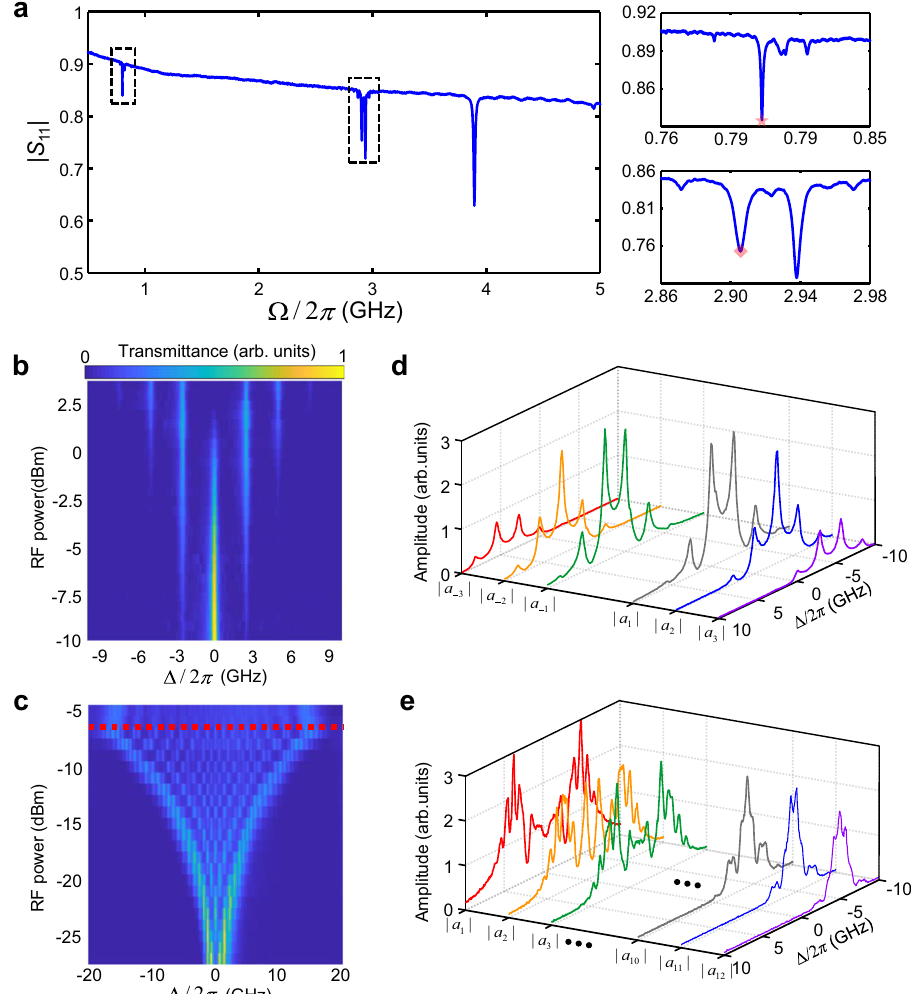
Fig. 2 | Characterizations of the acousto-optic modulation ef fi ciency and the harmonic signal generations. a Re fl ection (amplitude) spectrum of the IDT. The mechanical resonances in the zoom-in spectra at ~800MHz and ~2.90GHz have pronounced modulation ef fi ciency, whereas the resonance at 3.95GHz has a neg- ligiblyweakmodulationeffect.Thestarand diamond marksdenotetheprominent frequencies (803MHz and 2.903GHz) with enhanced modulation ef fi ciencies for the corresponding mechanical modes (see Methods). b Optical transmission spectraunderthemodulationdrivenat2.903GHzwithvaryingRFpower. c Optical transmission spectraunder the modulation driven at803MHz with RF power. The